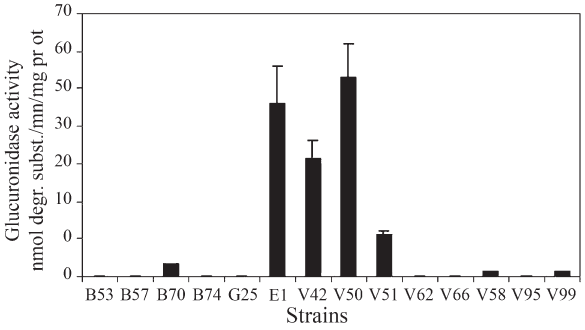
Figure 1 - β -glucuronidase activity of Ruminococcus gnavus strains, after 24 h of growth, based on the ability of cell extracts to hydrolyse PNPG. β -glucuronidase activity was expressed in nmol of degraded substrate/ min/mg of total proteins. Each value presented is the average of results from at least three independent